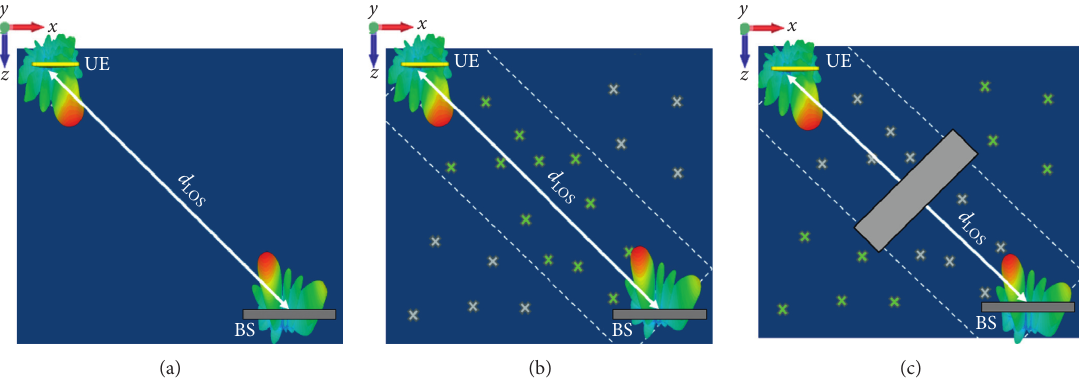
Figure 22: Representation of the three test scenarios in the xy plane (MP: multipath): (a) LOS; (b) LOS +MP; (c) NLOS